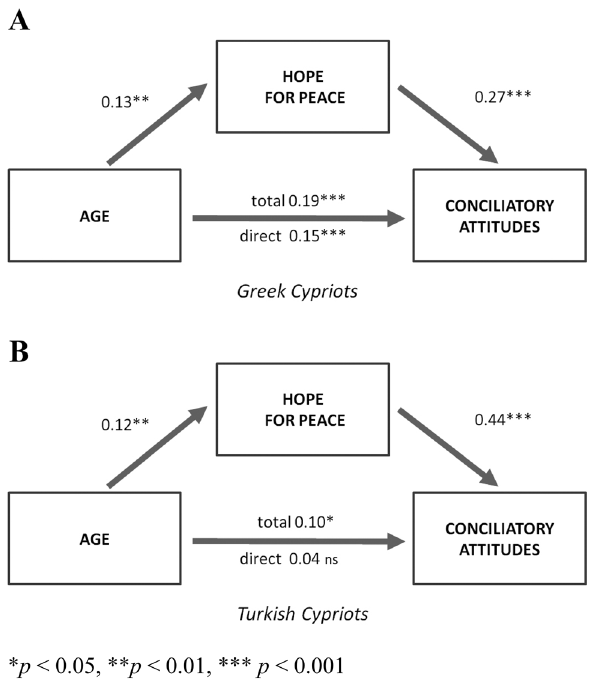
Figure 3. Mediation of age on conciliatory attitudes through hope for peace among Greek Cypriots ( A ) and Turkish Cypriots ( B ). Values are standardized beta